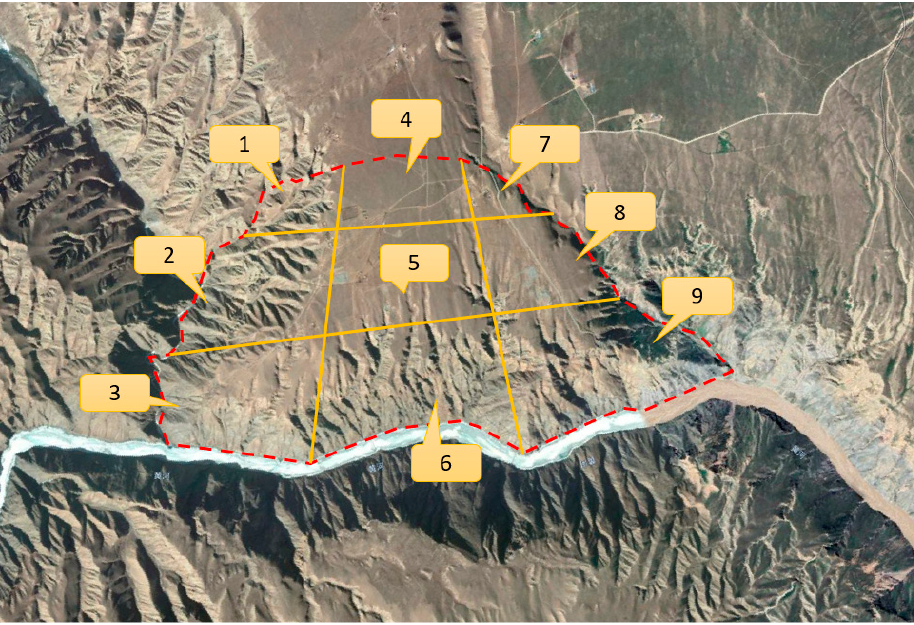
Figure 12. Typical measuring point distribution diagram.